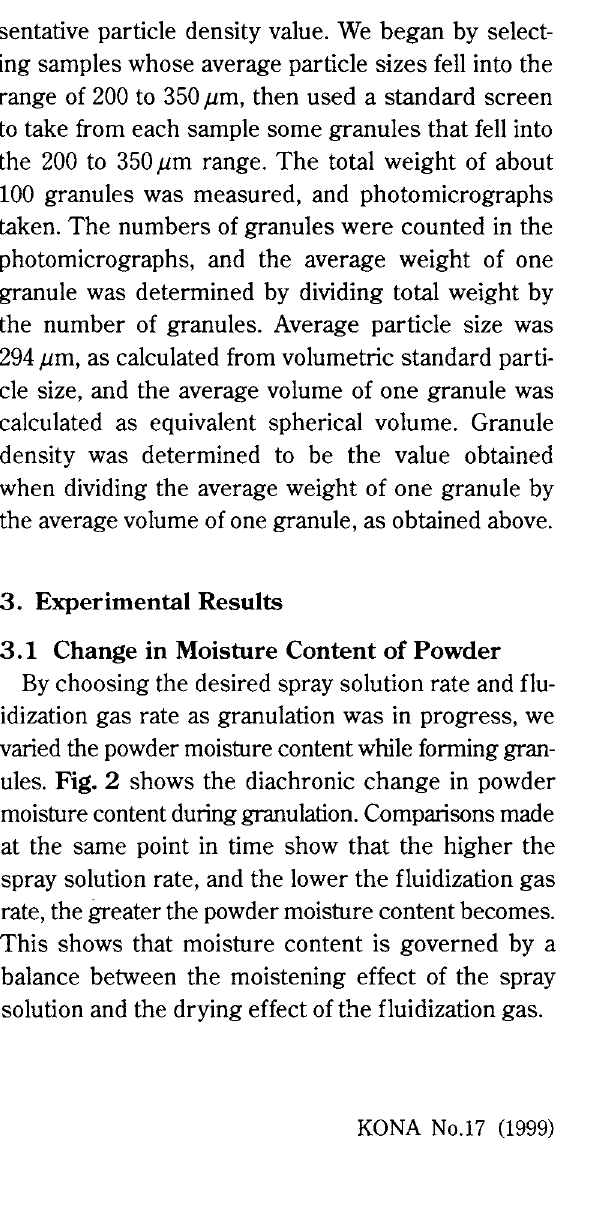
Schematic diagram of experimental